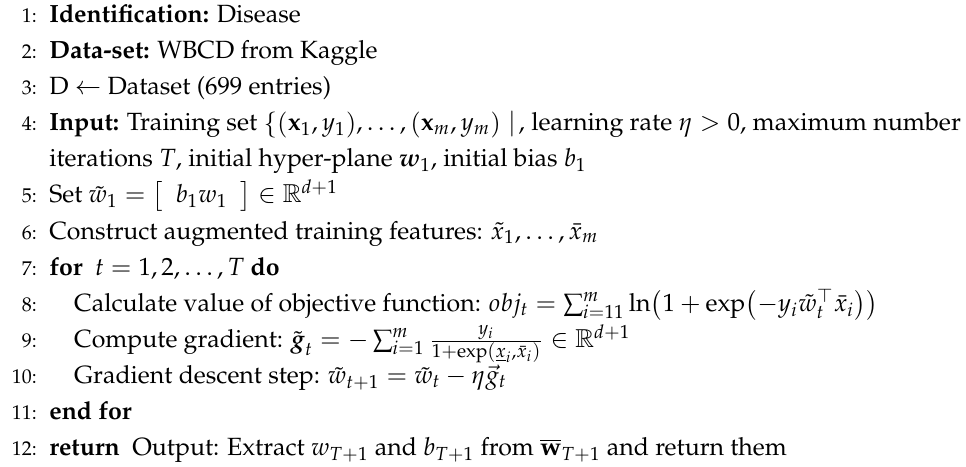
Algorithm 2 Logistic regression Algorithm to differentiate Benign or Malignant